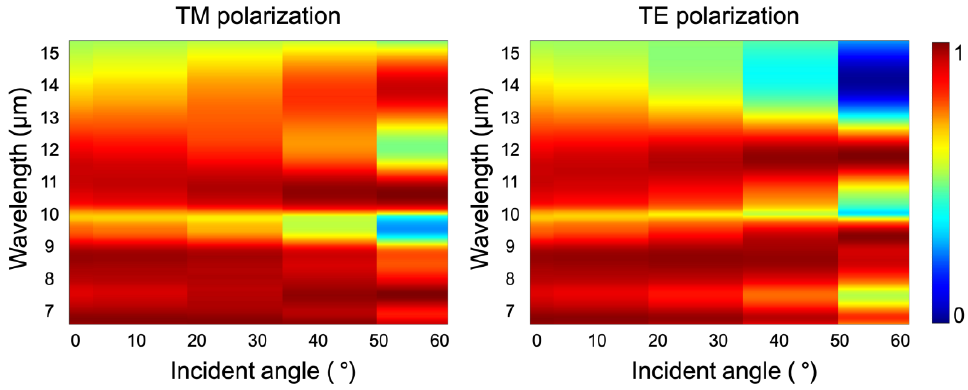
Figure 7. Absorption performance of the metasurface under different incident angles and polarization statuses. The color bar indicates the absorption intensity.